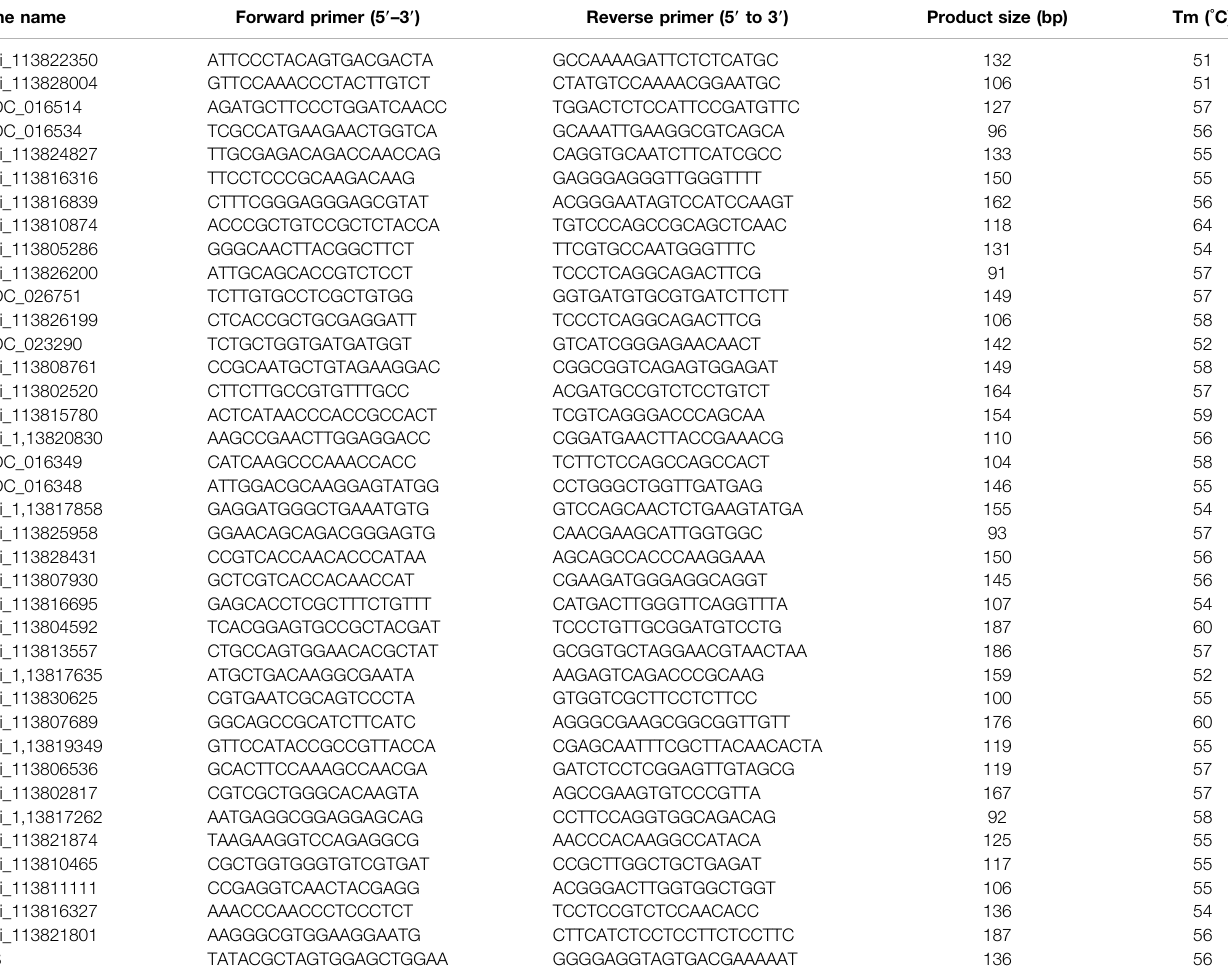
TABLE 1 | Primer sequences and annealing temperature used for